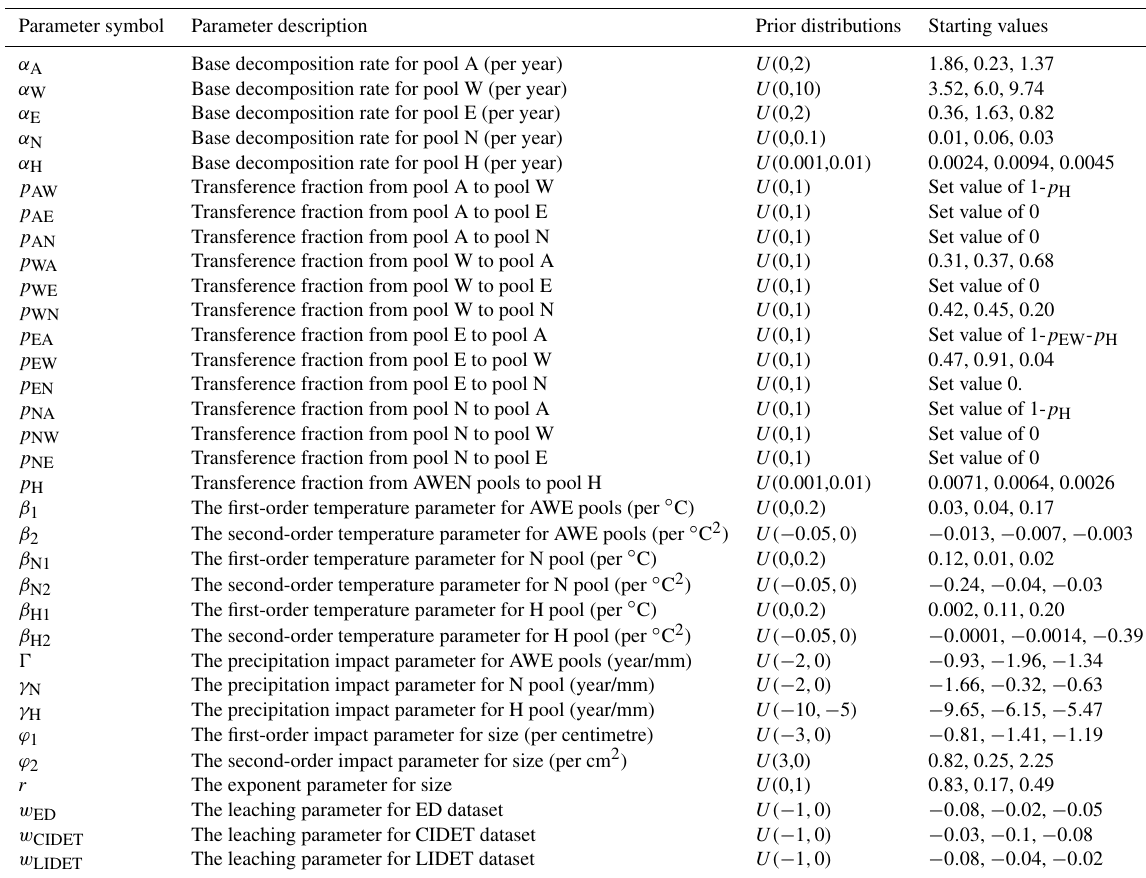
Table 1. The parameters, prior distributions, and initial values used in this calibration study. The initial values for the different chains were randomly drawn from the prior distribution ( U : uniform). If the starting value is listed as a set value, then the parameter was not varied in the calibration and the given value was used for all